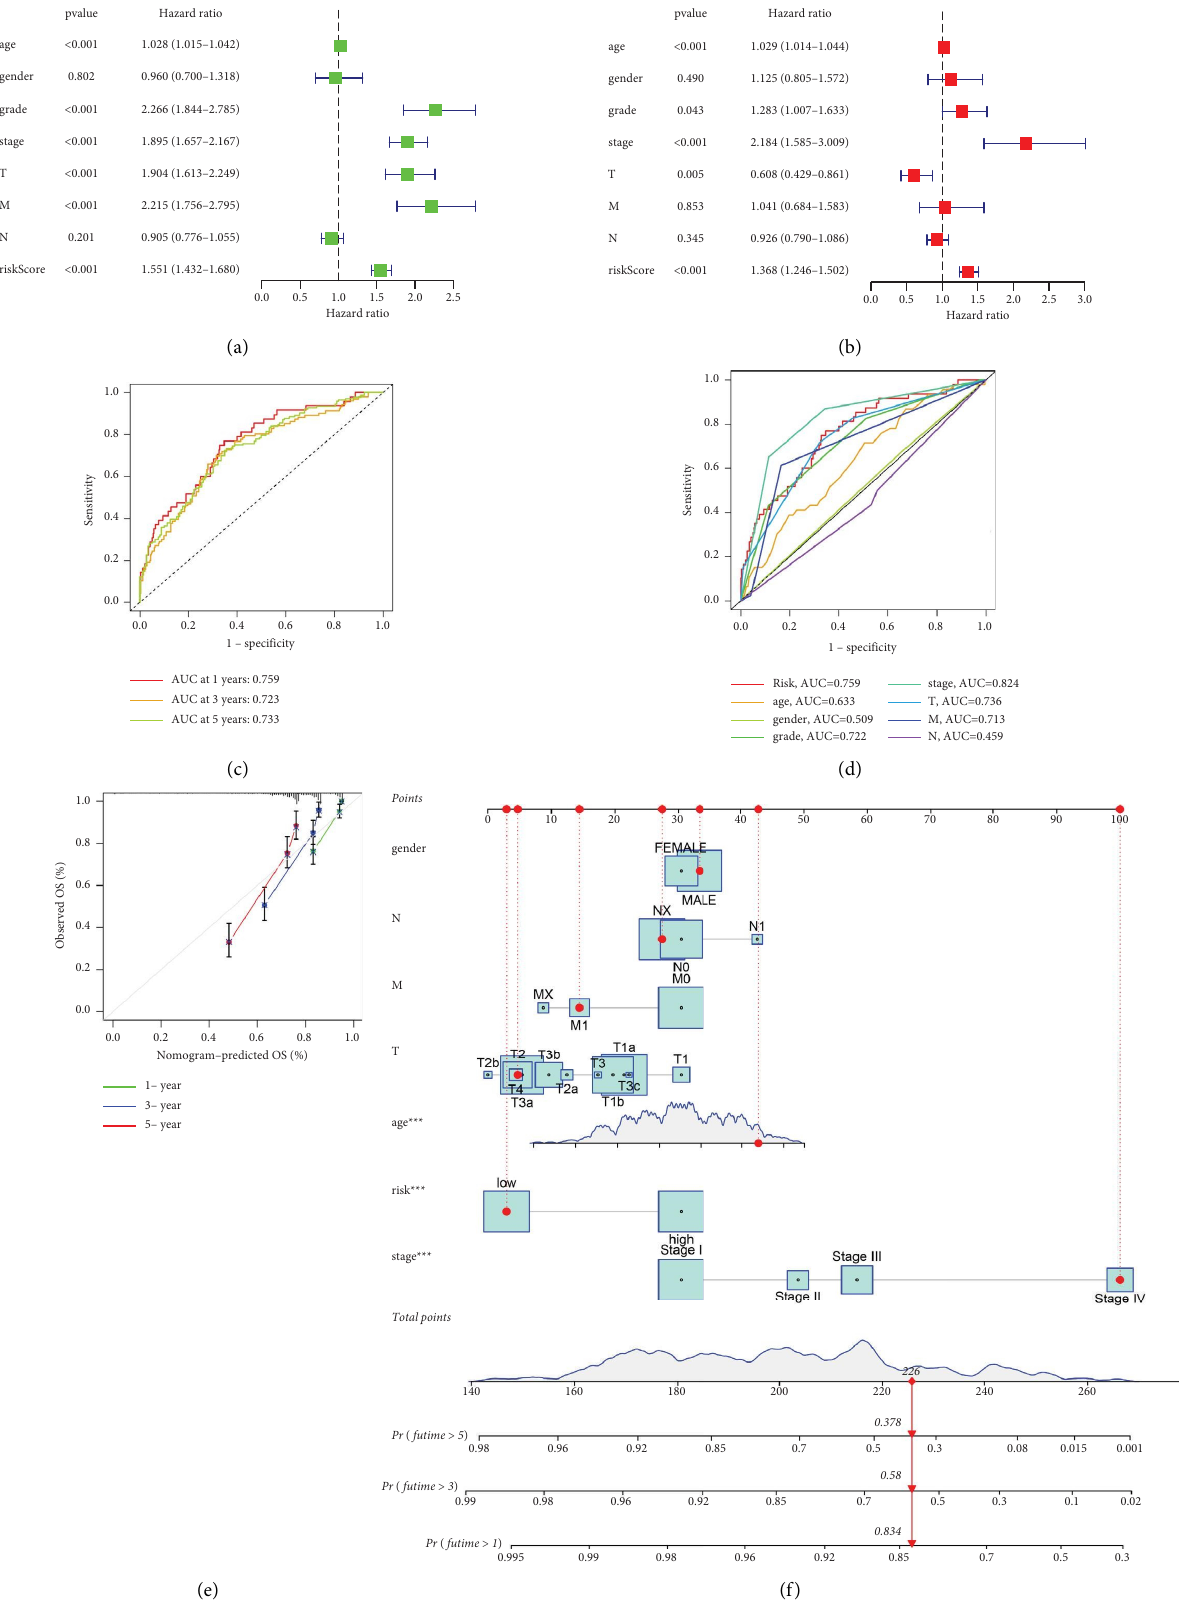
Figure 3: (a) Te univariate independent prognostic analysis based on the clinical characteristics and the risk score; (b) the multivariate independent prognostic analysis based on the clinical characteristics and the risk score; (c) the time-dependent ROC curve shows the 1-year, 3-year, and 5-year prognostic prediction value in RCC cohort; (d) the ROC curve demonstrated the prognostic prediction value of the risk score and clinical characteristics; (e) the calibration curve demonstrated that the nomogram shows a good predictive value for the prognosis of RCC patients; (f) the build of nomogram based on the risk score and clinical